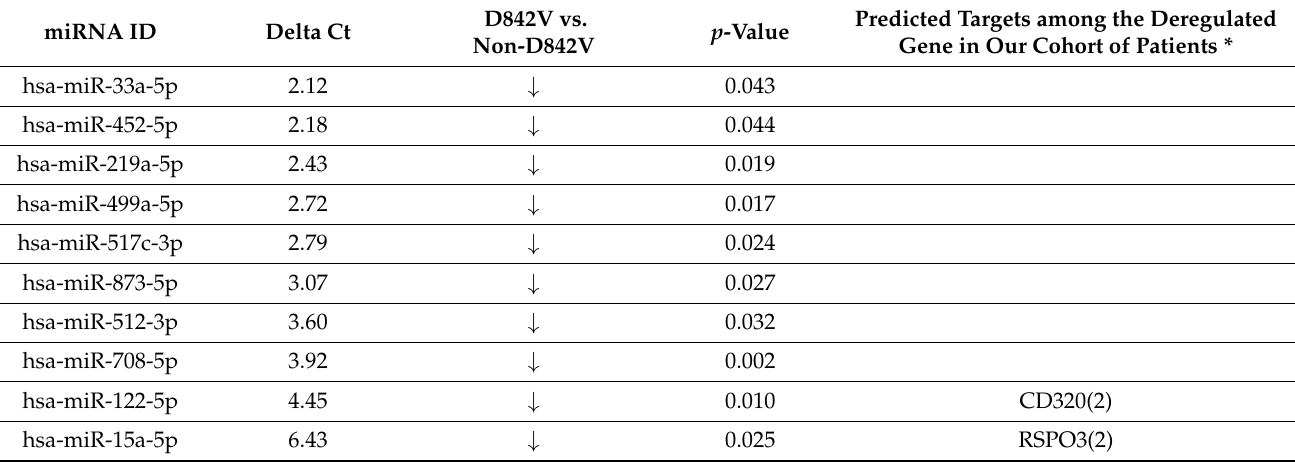
Hierarchical clustering of all samples separated PDGFRA D842V GISTs and non-D842V GISTs into two clusters (Figure 1).